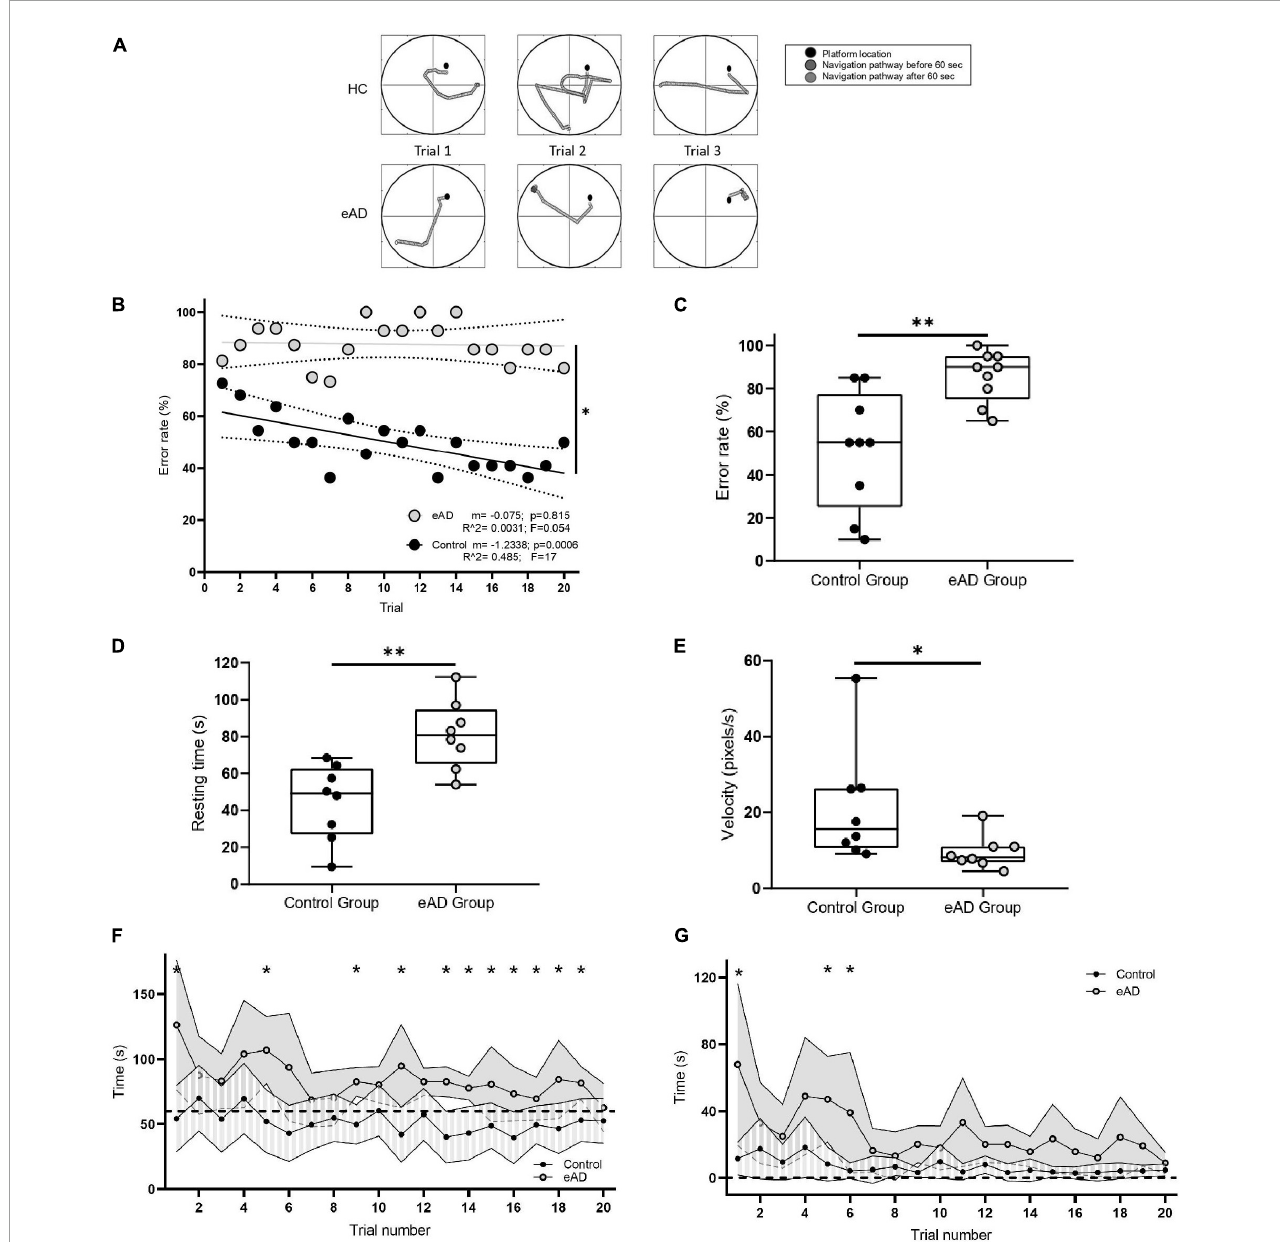
FIGURE1 Navigation performance. (A) Examples of navigation paths to find the platform during the performance of the Virtual Morris Water Navigation (VMWN) memory task for the early Alzheimer’s disease (eAD) and the healthy control (HC) groups in three different trials. Trajectories when the platform was hidden (dark gray) and when the platform became visible after 60 s of navigation (light gray). (B) Multiple learning linear regression analysis for the control and eAD groups. The decrease in the error rate was significantly different between both groups [multiple lineal regression (MLR), F (1, 36) = 7.072, p = 0.0116]. (C) Error rate. Percentage of participants who could not find the platform. For panels (C–E) , the box-whisker plot represents the median error rate of the nine participants in the 20 trials for each group, and the statistical significance, determined by the Mann–Whitney test ( ∗ p < 0.05, ∗∗ p < 0.01). (D) Average resting time in which the participants in each group were not performing movements. (E) The speed at which the participants moved to the supposed position of the hidden platform. (F) Time spent to reach the platform in each of the 20 trials. Dashed line: 60 s–limit to